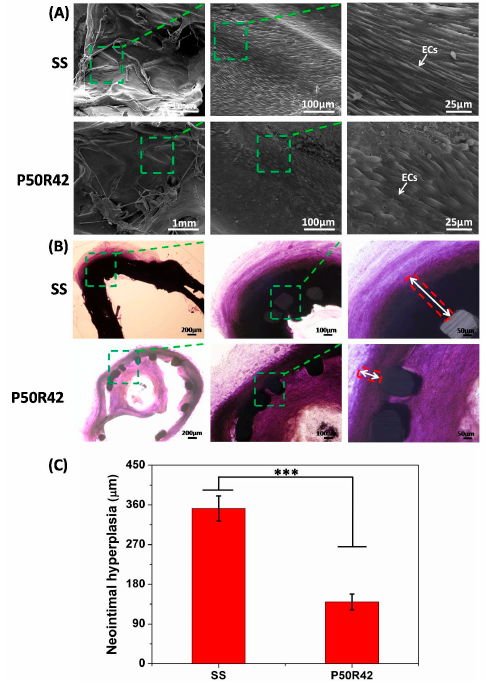
Figure 9. The results of control SS- and P50R42-coated stents after being implanted bilaterally in a dog’s femoral arteries for 69 days assessed by ( A ) SEM and ( B ) histomorphometric analysis. ( C ) The thicknesses of neointimal hyperplasia on control SS and P50T42 stents (*** p < 0.001).